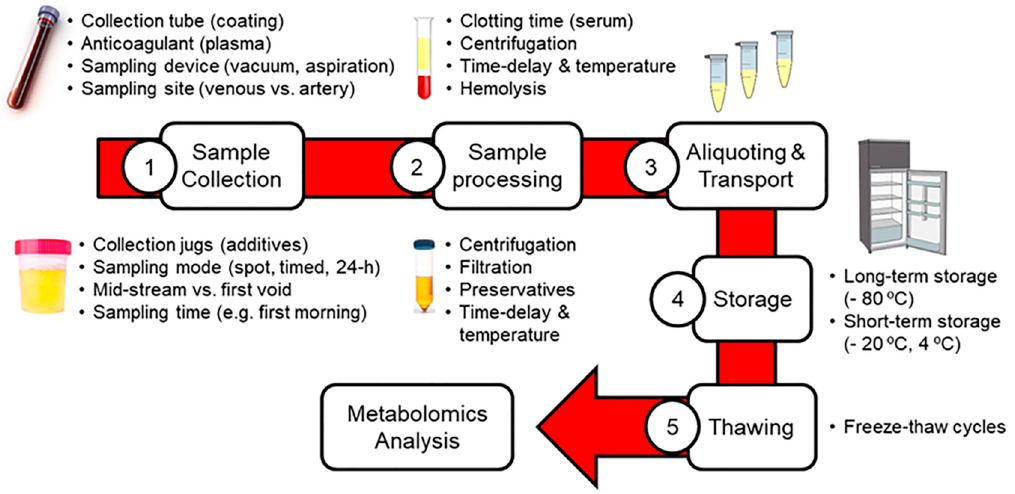
Figure 1. Summary of pre-analytical factors influencing blood and urinary metabolomics.